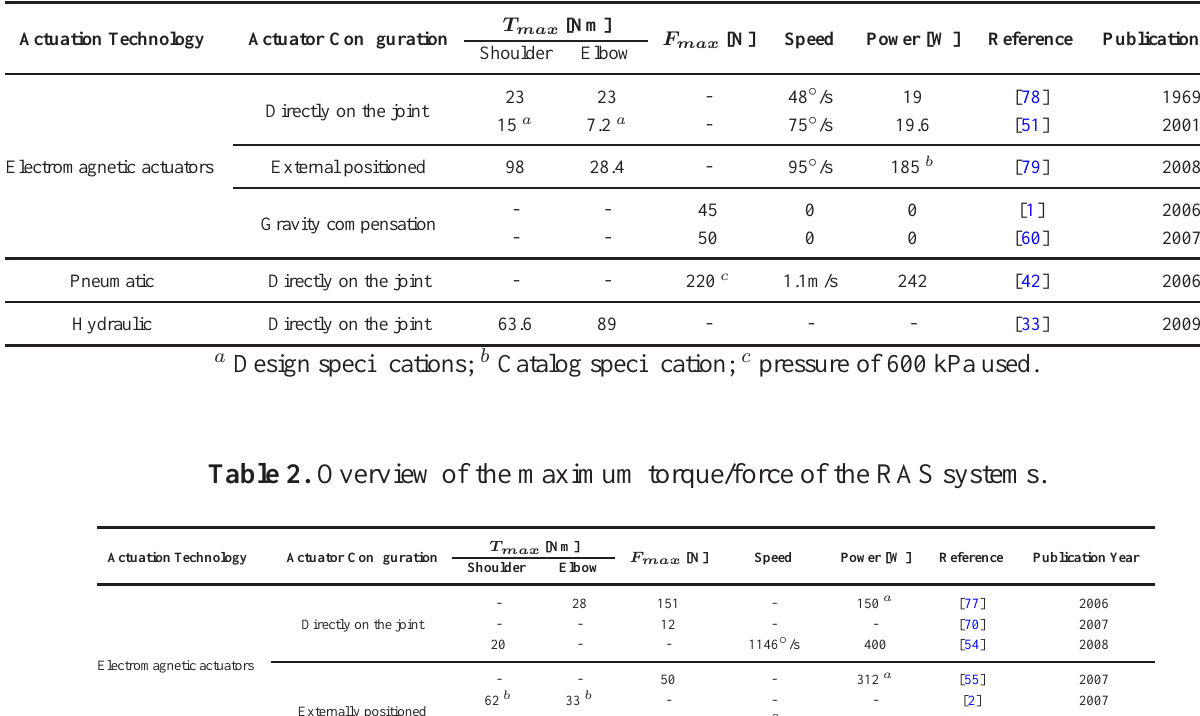
Table 1. Overview of the maximum torque/force of the AAS systems.